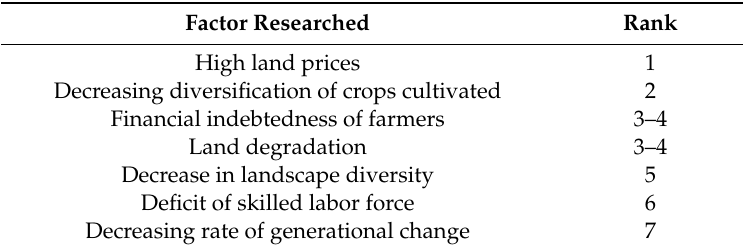
Table 3. Final ranks of factors according to their negative